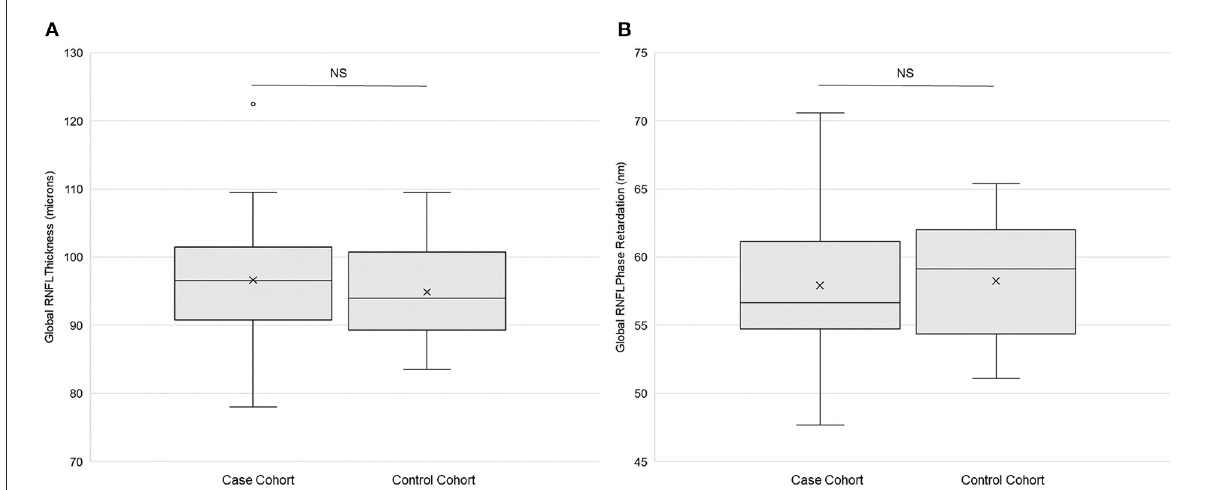
FIGURE3 Retinal imaging primary outcomes. (A) Global retinal neve fiber layer (RNFL) thickness ( n = 25) and (B) global RNFL phase retardation ( n = 24) in both the case and the control cohorts. Each box represents the interquartile range, and the internal line is the median. The internal “X” is the mean. The whiskers represent the 90th and 10th percentiles, and the filled circle is an outlying value. Phase retardation data for one case subject (114) were not collected due to a technical difficulty. NS is not statistically significant ( p > 0.05, paired t -test).